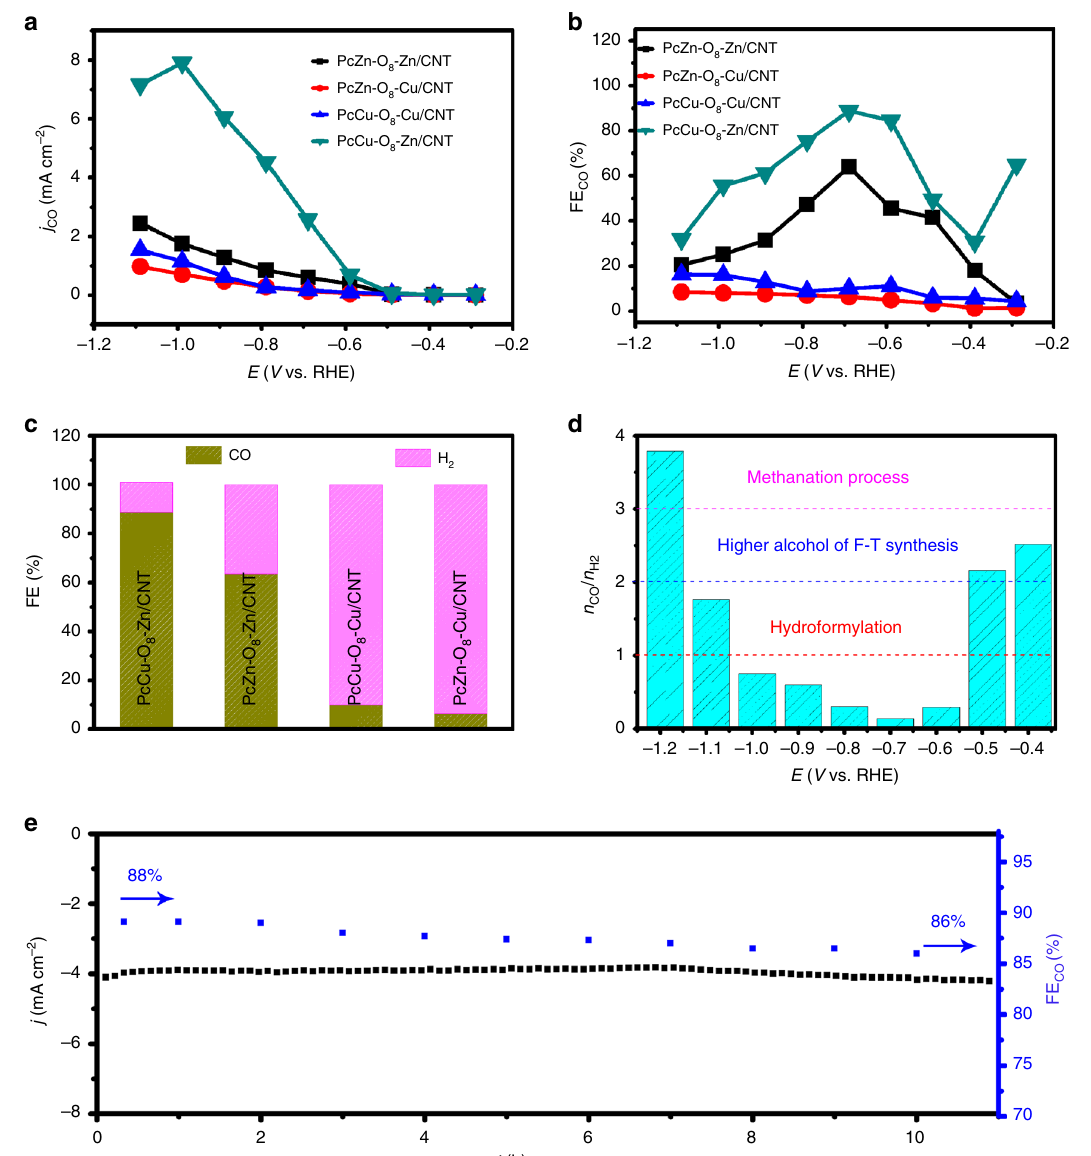
Fig. 3 CO 2 RR performance. a Partial current and b Faradaic ef fi ciency of CO for PcCu-O 8 -Zn/CNT, PcCu-O 8 -Cu/CNT, PcZn-O 8 -Zn/CNT and PcZn-O 8 - Cu/CNT at different potentials. c Faradaic ef fi ciency of CO and H 2 for PcCu-O 8 -Zn/CNT, PcCu-O 8 -Cu/CNT, PcZn-O 8 -Zn/CNT and PcZn-O 8 -Cu/CNT at − 0.7 V vs. RHE. d Molar H i ~ t ) stability and the according 2 /CO ratio at different applied potentials of PcCu-O 8 -Zn/CNT. e Amperometry (